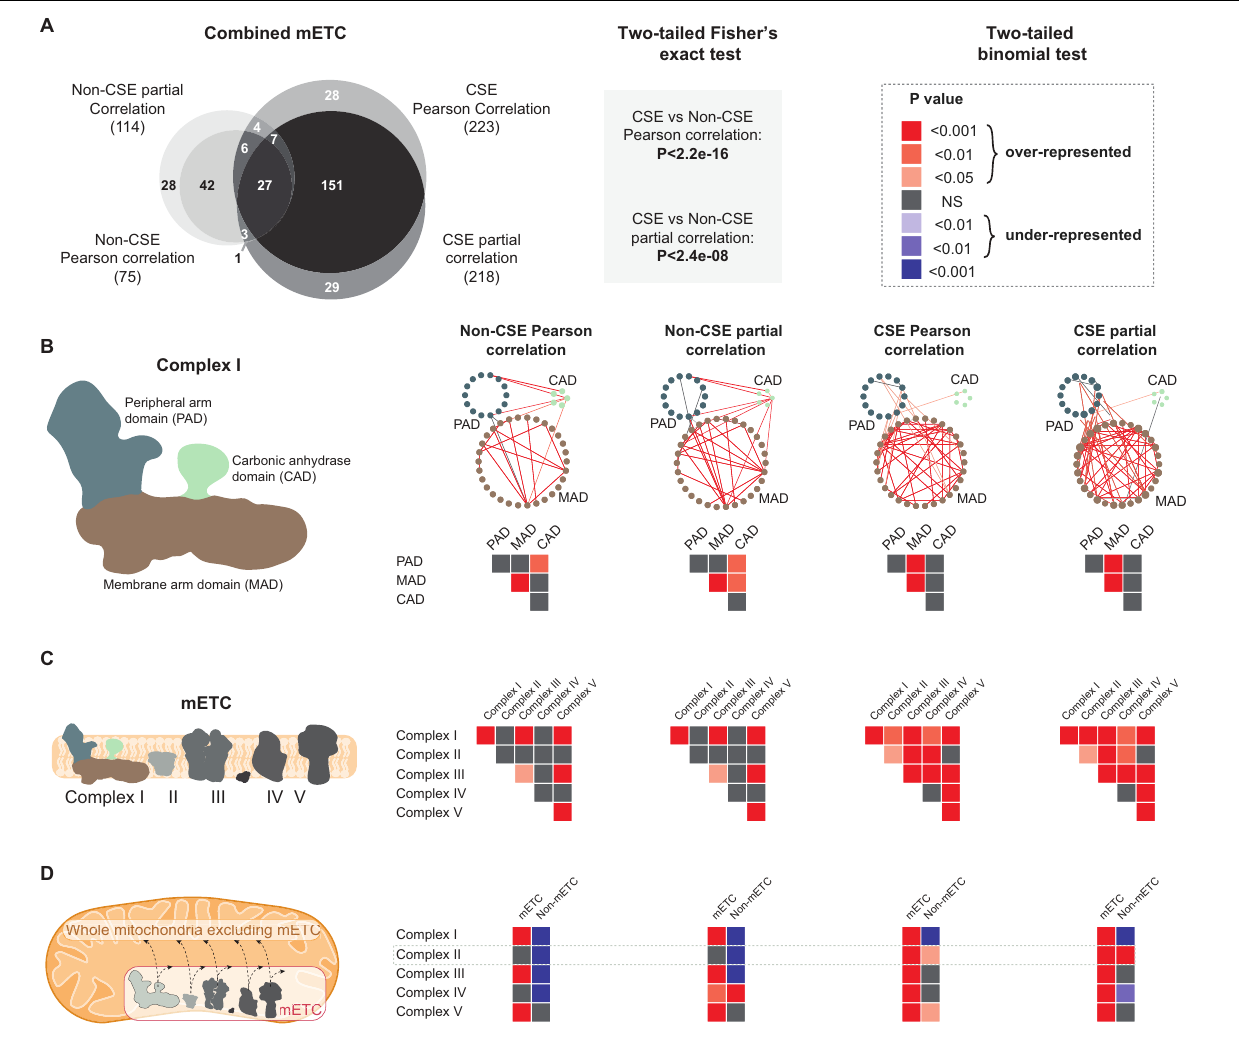
Frontiers in Plant Science |